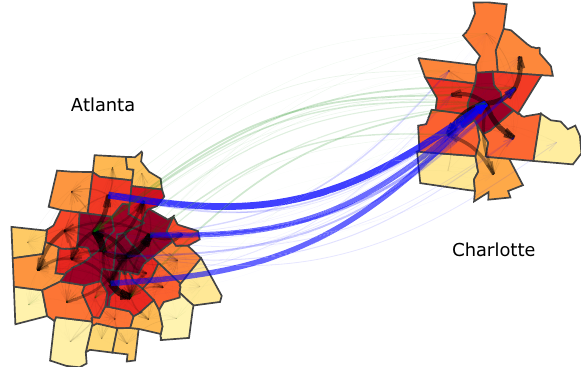
Fig. 1 Intra- and inter-city net fl ows contribution to the growth of counties. This schematic fi gure illustrates the components of domestic migration affecting the growth of counties of Atlanta and Charlotte metro areas. Intra-city net fl ows are represented by black arrows. Inter-city net fl ows from Atlanta to Charlotte are represented by blue arrows, and the green arrows represent inter- city net fl ows in the opposite direction. The opacity and width of the arrows are proportional to the intensity of the net fl ows. The background color resembles the population density of the counties, in which denser counties have darker colors. Intra-city net fl ows have a trend from higher to lower density counties, and the most intense inter-city net fl ows were directed to Charlotte. This fi gure was based on migration fl ow data of the 2015 – 2019